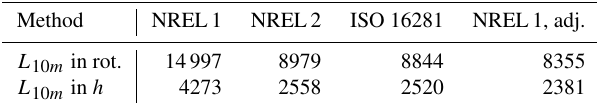
Table 3. Fatigue lifetimes of all methods